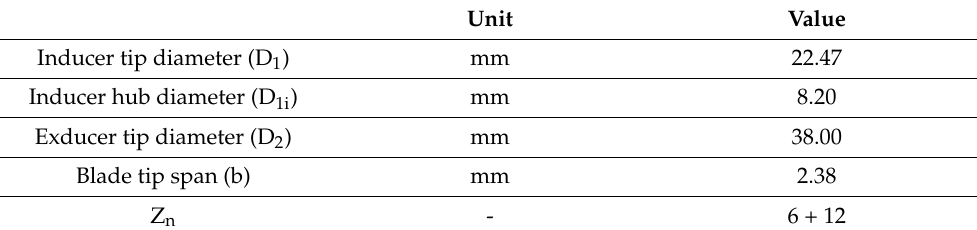
Table 2. Main Features of the Tandem Compressor rotor.